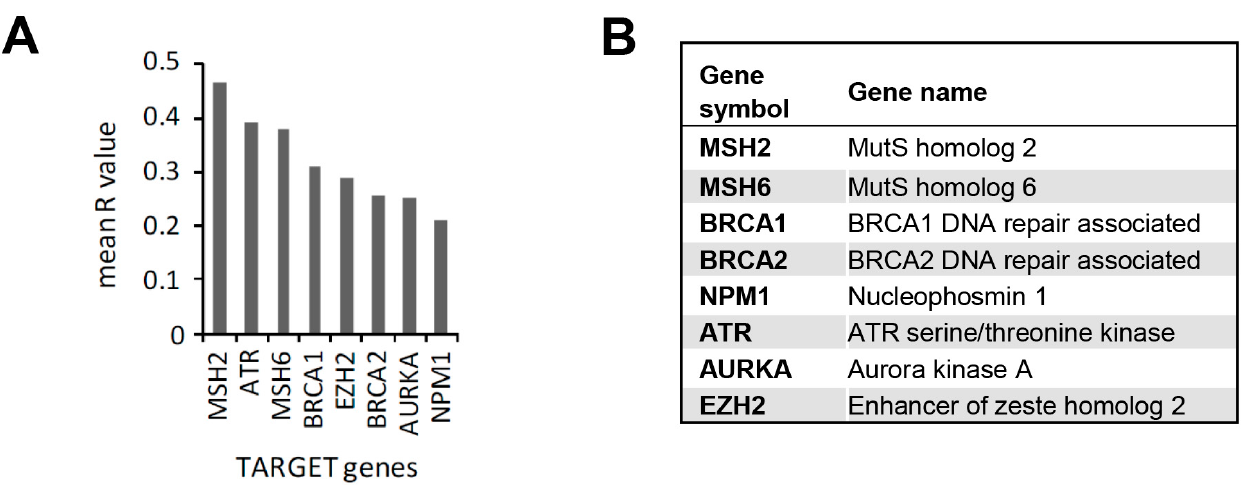
Figure 7. Correlation between the mRNA expression of the XPO1 gene, coding for CRM1, and the genes in the TARGET dataset. ( A ) Graph showing correlations between the co-expression of the gene coding for CRM1 ( XPO1 ) and TARGET genes with a mean R value > 0.2. ( B ) List of the symbol and corresponding complete gene names of identified genes co-expressing with CRM1 with a mean Pearson´s R value > 0.2.